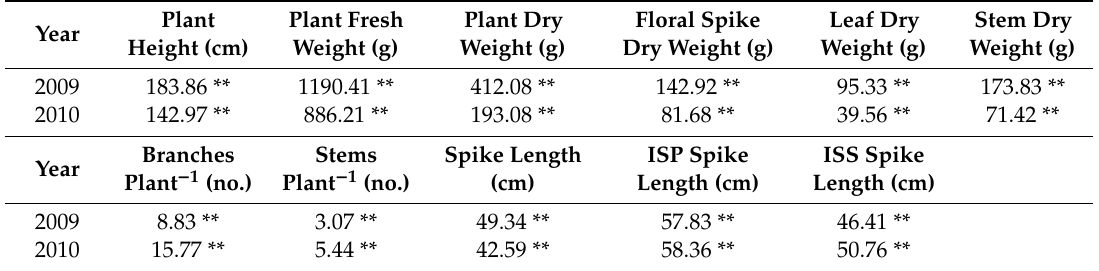
Table 2. Orleans (Palermo, PA). Yearly averages for biometric and production parameters.